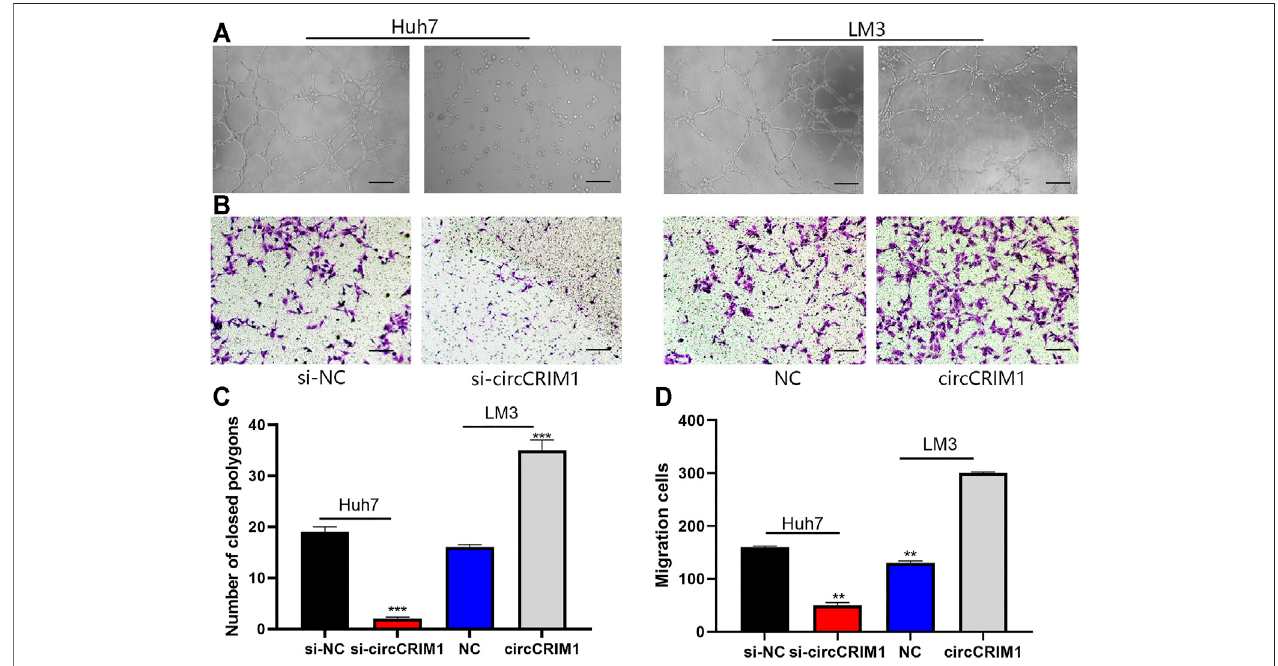
FIGURE 3 | CircCRIM1 enhances the angiogenic capability of HCC cells. (A,C) Tube formation assays with HUVECs in indicated conditioned media. Numbers of brancheswerecalculatedusingImageProPlus6.Scalebar,50 μ m. (B,D) EndothelialrecruitmentassayswithHUVECsperformedforeachgroup.Scalebar,50 μ mCell migration was quanti fi ed using cell numbers. All experiments were performed three times. Data are mean ± SD. * p < 0.05, ** p < 0.01, and *** p < 0.001.